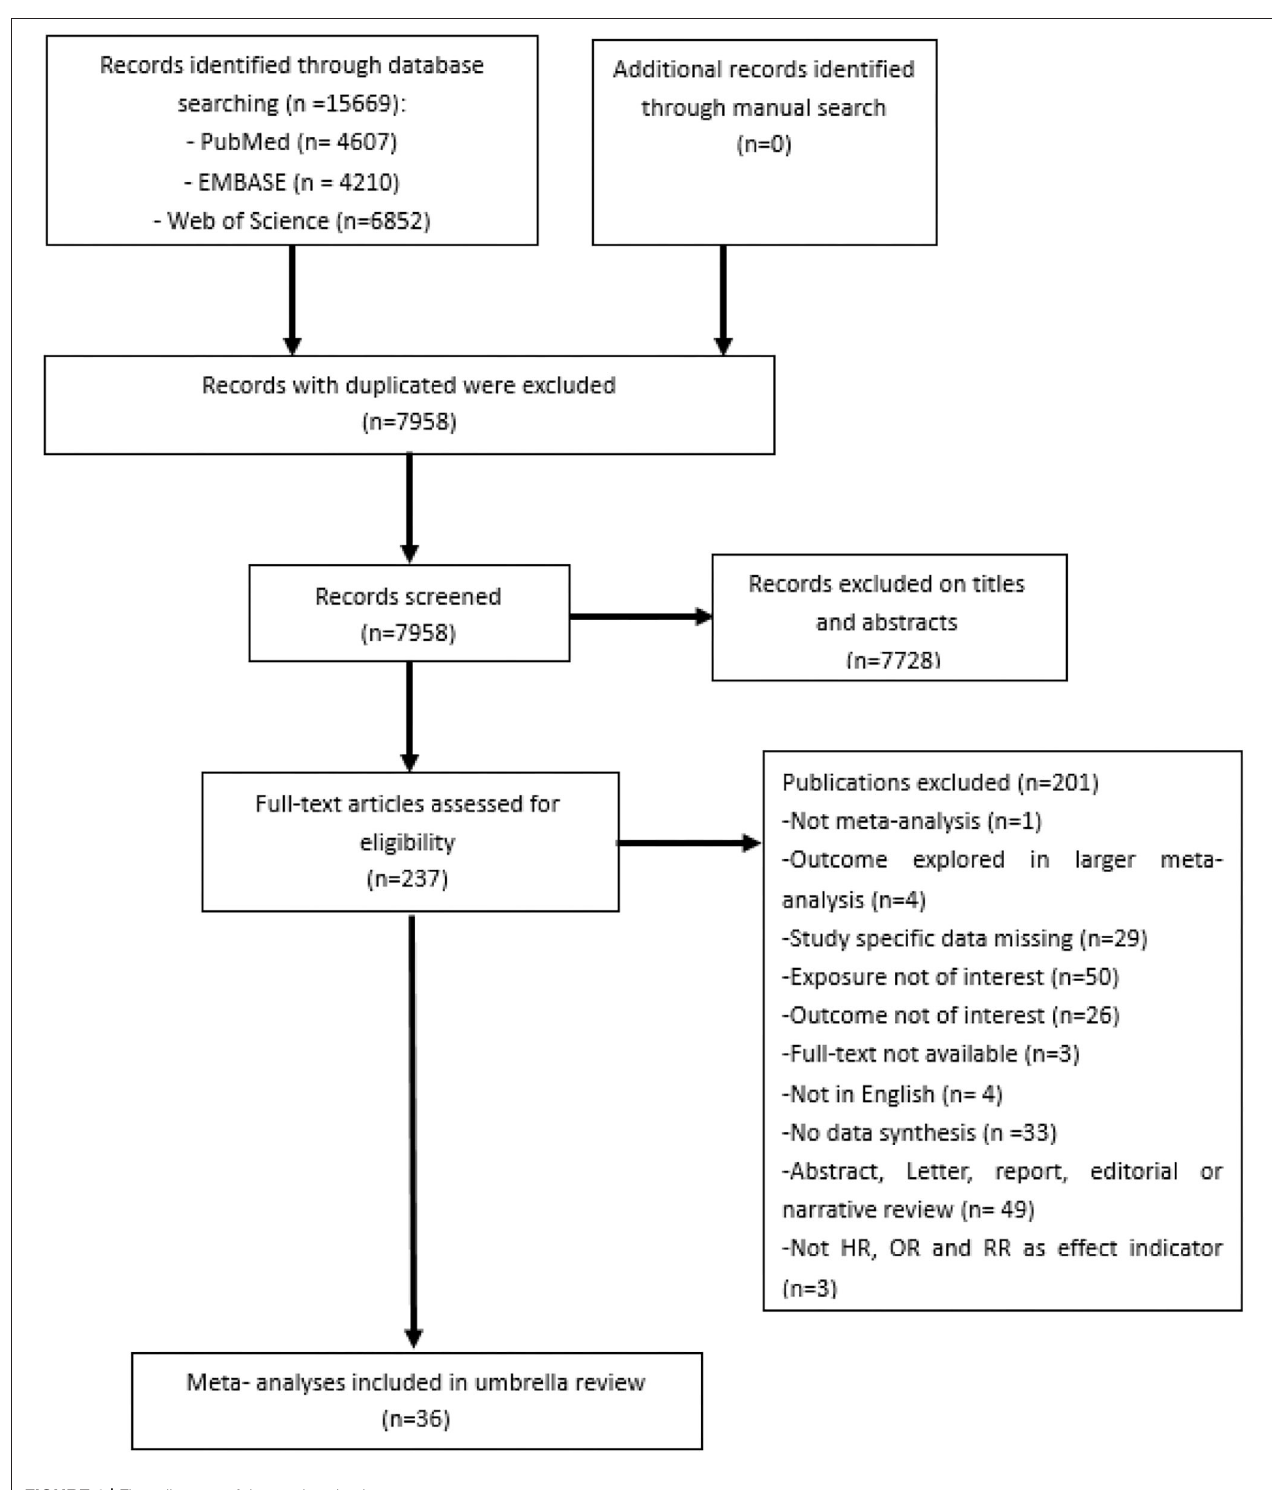
FIGURE 1 | Flow diagram of the study selection process.